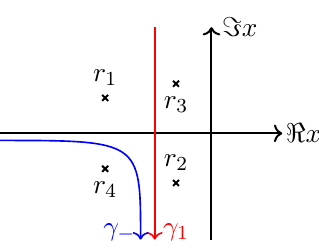
Figure 2 . The distribution of the four roots of y 2 ( x ) and the two integration contours γ 1 and γ − defining the period ω 1 and z − ∞ . The contour γ 2 which defines the period ω 2 runs along the real